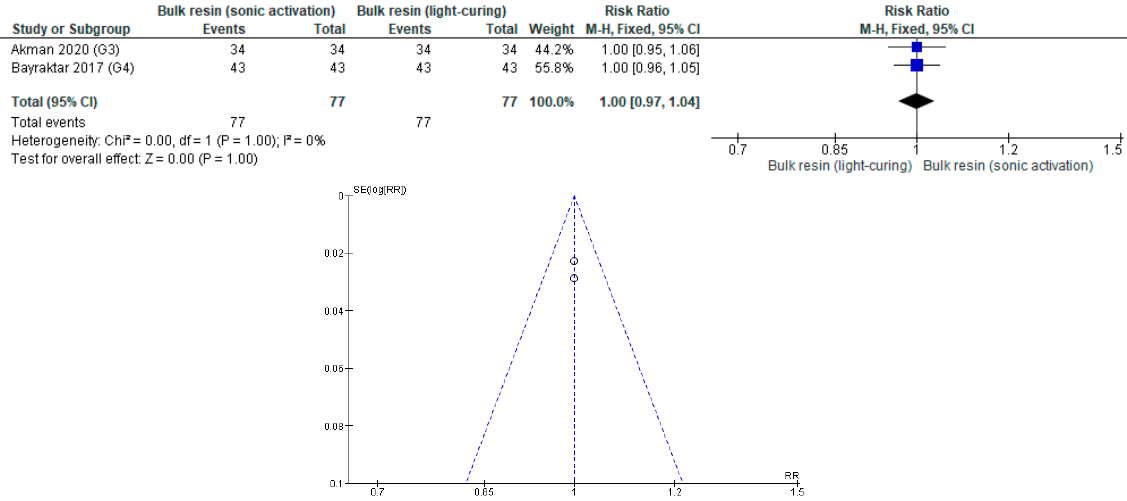
Figure A4. Absence of Fractures: Conventional Resin versus Bulk Resin According to the Technique Used.